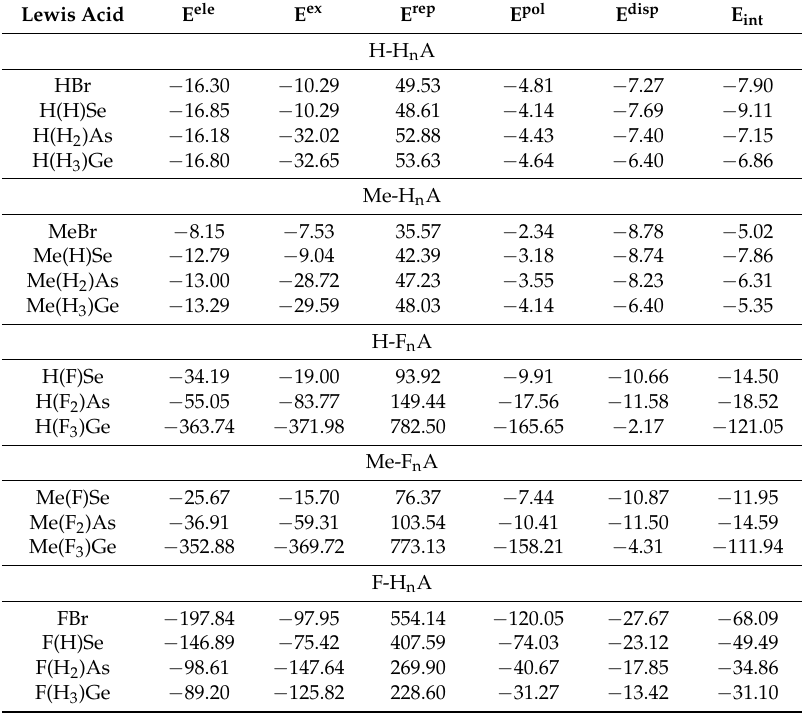
Table 4. Electrostatic (E ele ), exchange (E ex ), repulsion (E rep ), polarization (E pol ), dispersion (E disp ), and interaction energies (E int ); all are in